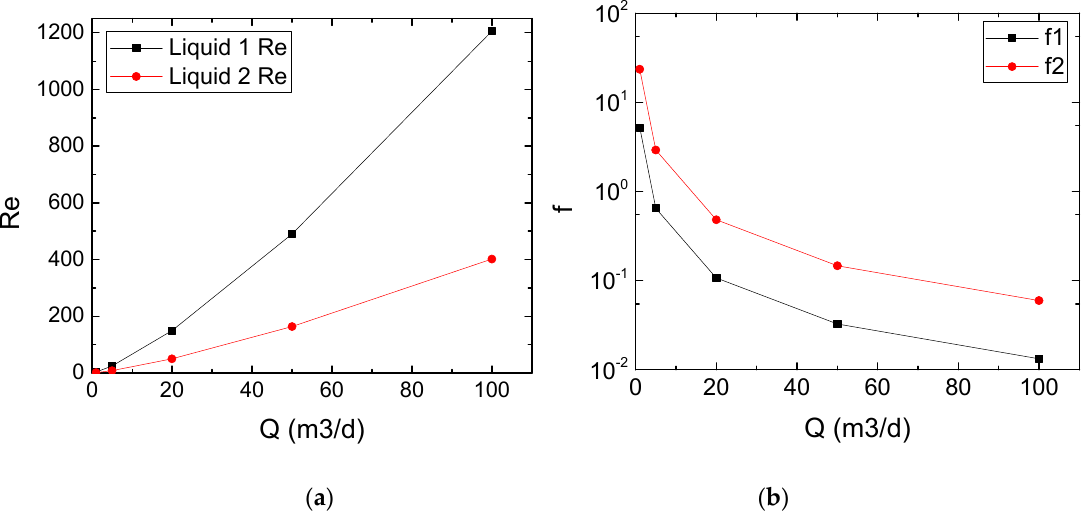
Figure 11. The influence of injecting rates on Reynolds number and coefficient of friction. Generally, the injected polymers are laminar flow. ( a ) shows the relationship between injecting rates and Reynolds number. ( b ) shows the relationship between injecting rates and coefficient of friction.